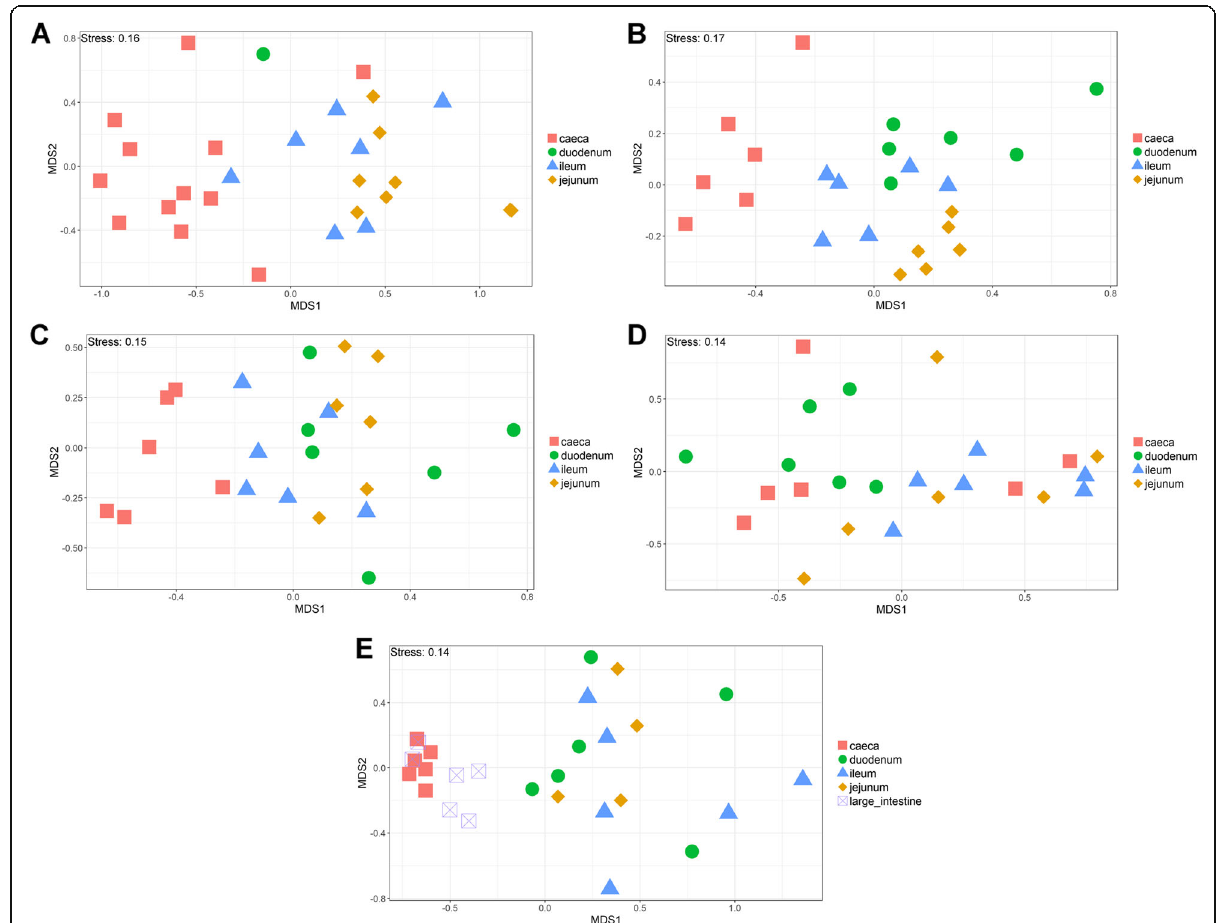
Fig. 1 NMDS comparing sample types within timepoints. NMDS of chicken intestinal content samples clustered by microbial